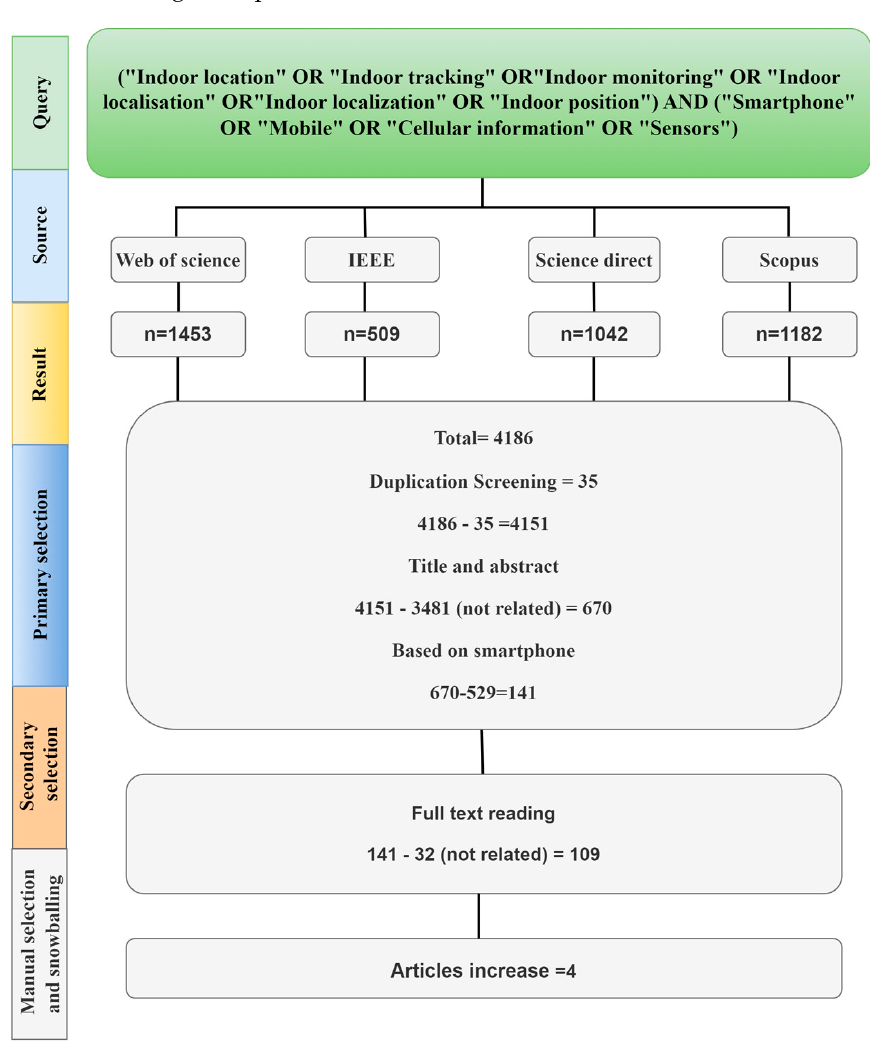
Figure 2. Flowchart of the search query and inclusion criteria for articles selection.